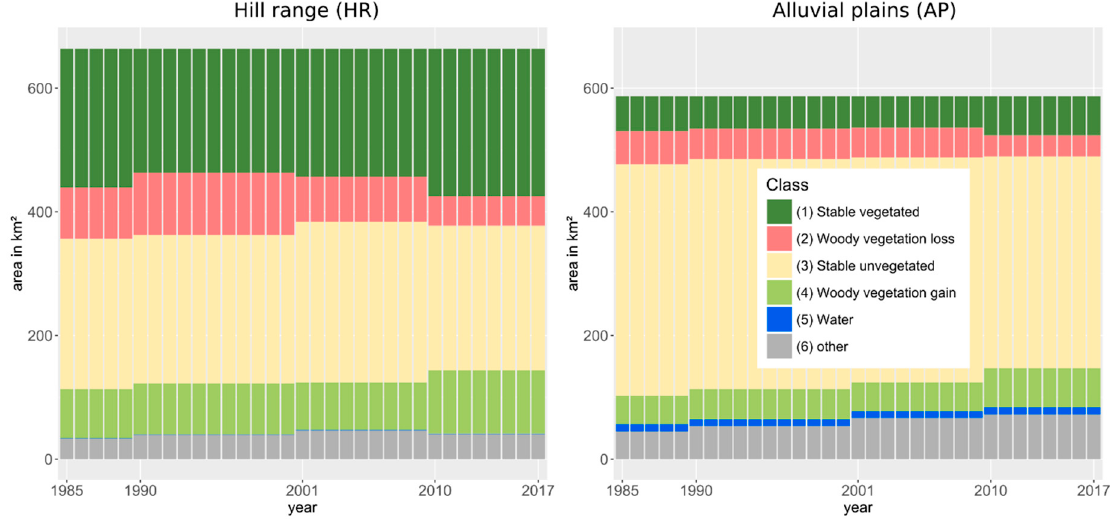
Figure 4. Vegetation cover changes and total extent of the transition classes in the hill range (HR) and alluvial plains (AP).